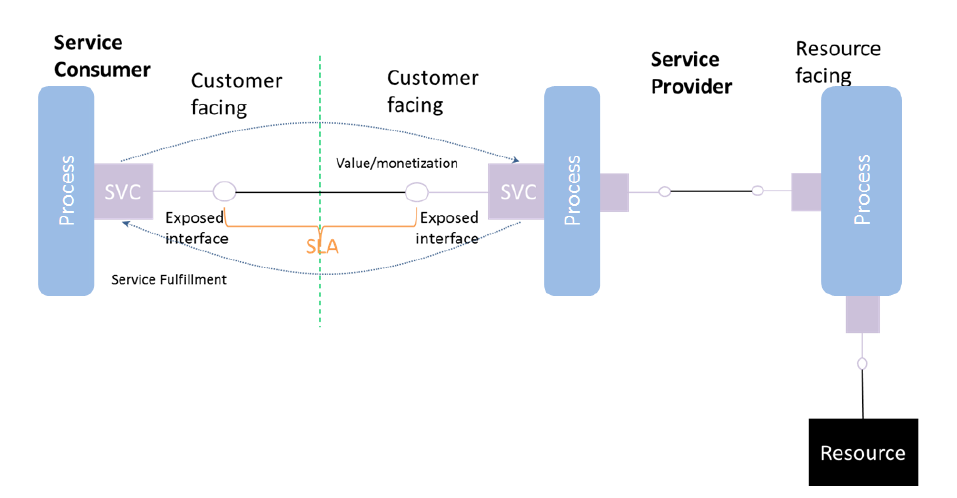
Figure 5 . Cooperation between processes over a